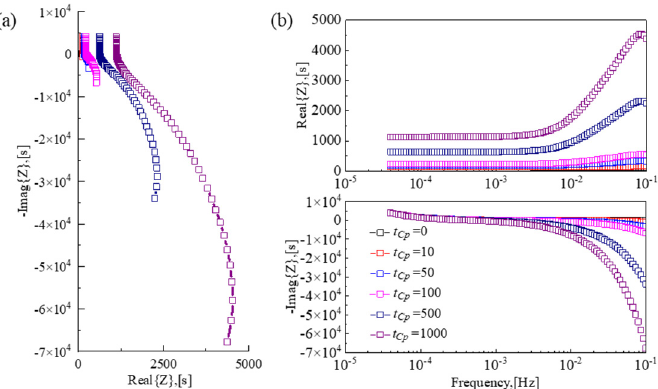
Figure 8. Impedance spectroscopy of different τ Cp (Bi = 1). ( a ) Nyquist figure, ( b ) variation curve of real part and imaginary part with frequency.